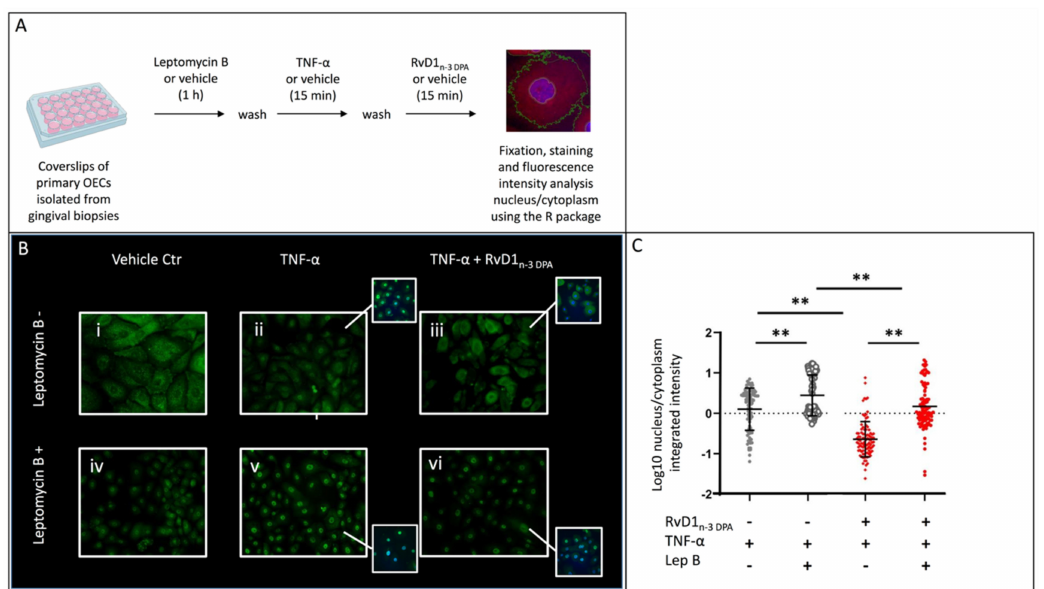
Figure 5. RvD1 n-3 DPA inhibits p65 translocation to the cell nucleus. ( A ) Experimental setup. Primary oral epithelial cells were treated for 1 h with leptomycin B or left untreated. Then, the cells were washed and incubated for 15 min with TNF- α or left untreated. After a final washing, RvD1 n-3 DPA or vehicle was added for 15 min after which the cover slips with the cells were processed for immunocytofluorescence and analysis with CellProfiler (see Material and Methods). ( B ) Microscopic pictures of p65 immunocytofluorescence (green) of cells as described in ( A ). Stainings combined with DAPI are displayed in Figure S1. Original magnification × 20. ( C ) Distribution of p65 in oral epithelial cells treated as indicated on the x -axis. The y -axis shows the ratio of nuclear/cytoplasmic p65 staining. Part of Figure 5A was created with BioRender.com. ** Statistically significant differences ( p < 0.05) as assayed by repeated measures ANOVA with adjustment for multiple comparisons based on False Discovery Rate